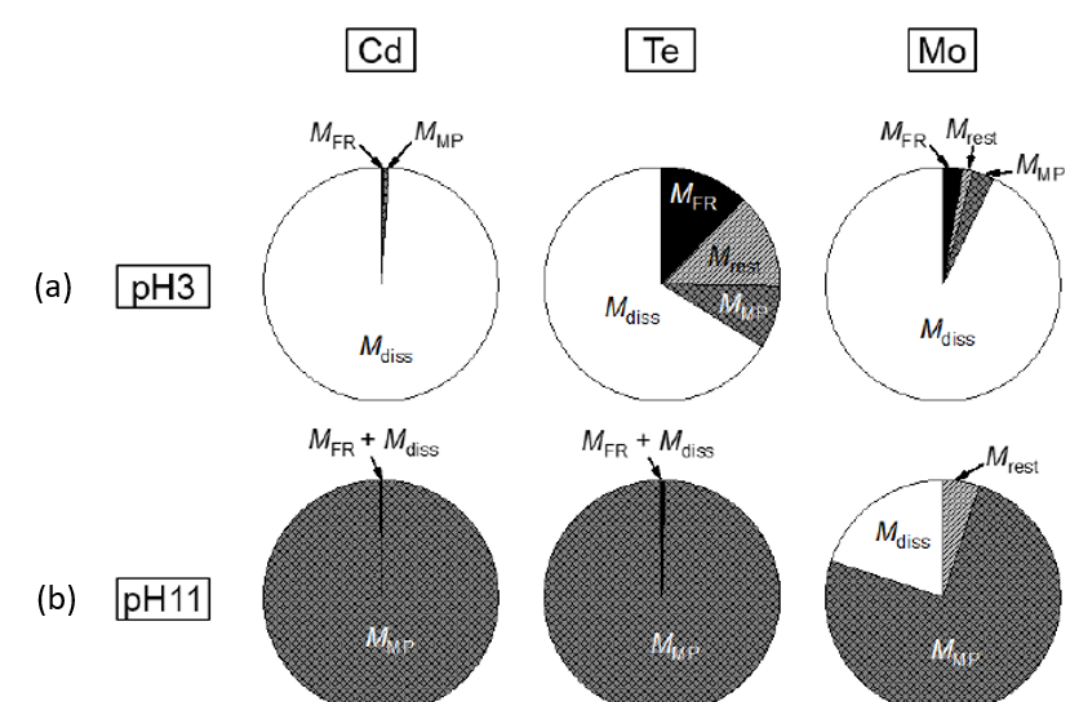
Figure 14. Mass balance of the CdTe module piece after 700 days in leaching solutions with ( a ) pH 3 and ( b ) pH 11 at T RT = 25 ◦ C without agitation. In solutions with pH 3, the largest fraction of Cd, Te, and Mo is dissolved and found as M diss ; only a small fraction M MP remains in the module pieces. No Cd-particles (mass M FR ) are measured within the filter residue, whereas for Te and Mo, a small part is found in the residue. In solutions with pH 11, the major part of the elements Cd and Te remains in the module piece and is not leached out. Molybdenum is also measured in the